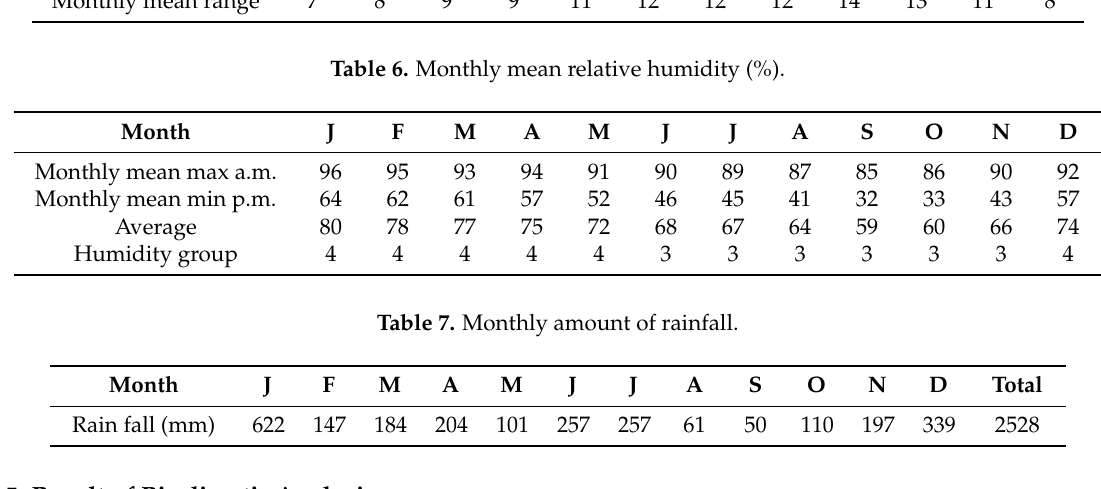
Table 7. Monthly amount of rainfall.